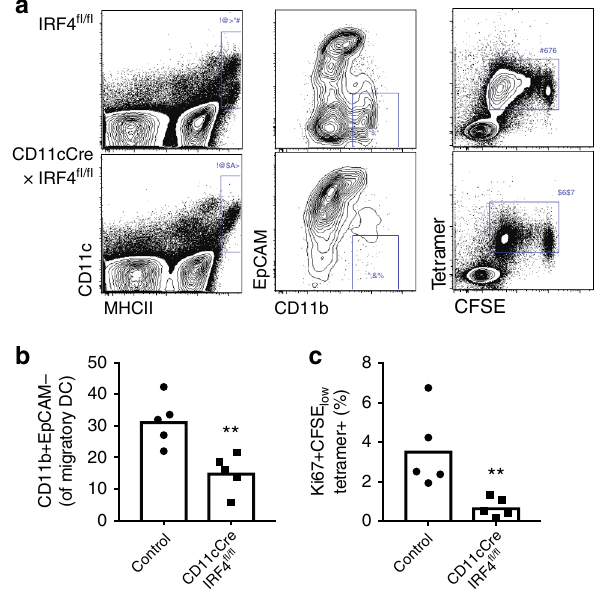
Fig. 5 IRF4-dependent DCs are required for presentation of topical antigen. Reduction of EpCAM - CD11b + DCs in the lymph nodes of mice lacking IRF4 in the CD11c compartment (representative cytometry a , summary b ). Reduction of T cell priming in mice lacking IRF4 in the CD11c compartment of brachial lymph nodes at Day 3 after topical OVA